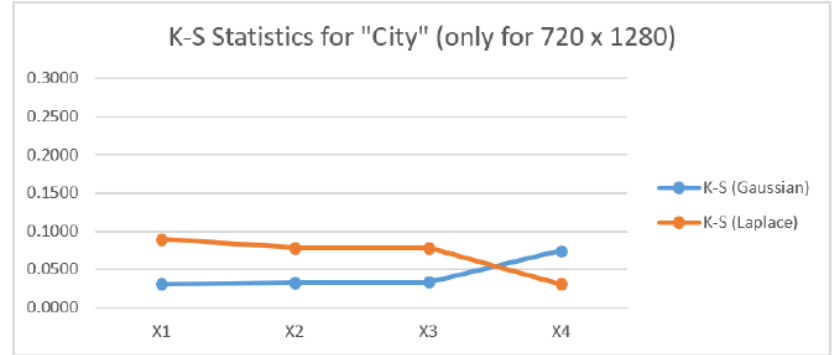
Figure 9. Kolmogorov-Smirnov Test Statistics for City.